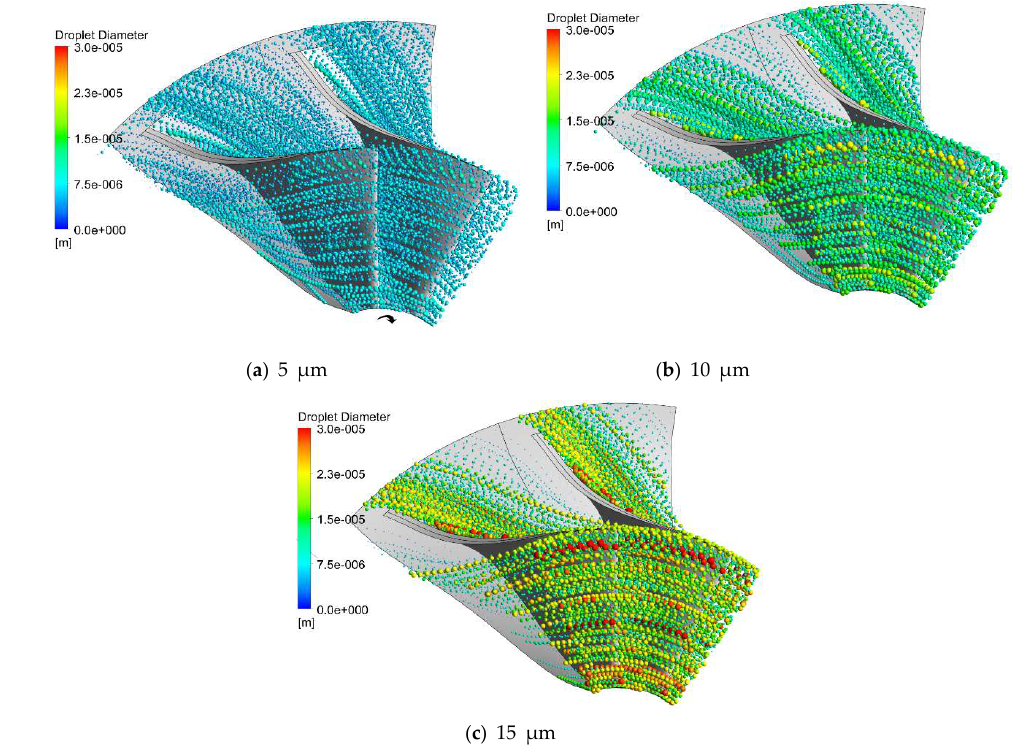
Figure 17. Droplet trajectories in the impeller